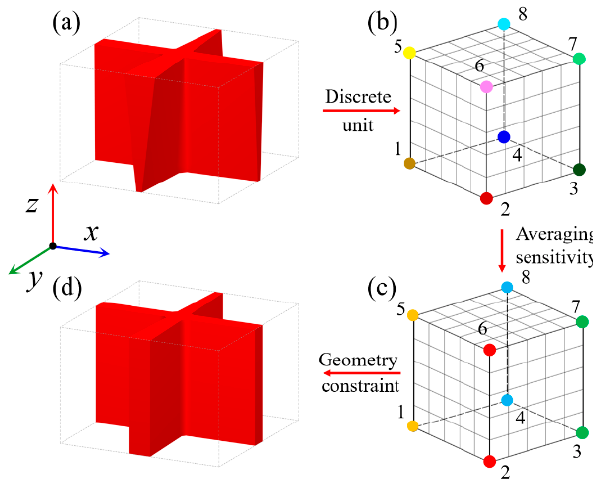
Figure 7. Geometry constraints on stiffening rib unit cell. ( a ) Unit cell without geometry constraint. ( b ) Discrete elements with different sensitivities. ( c ) Discrete elements with average sensitivities. ( d ) Unit cell with geometry constraint.